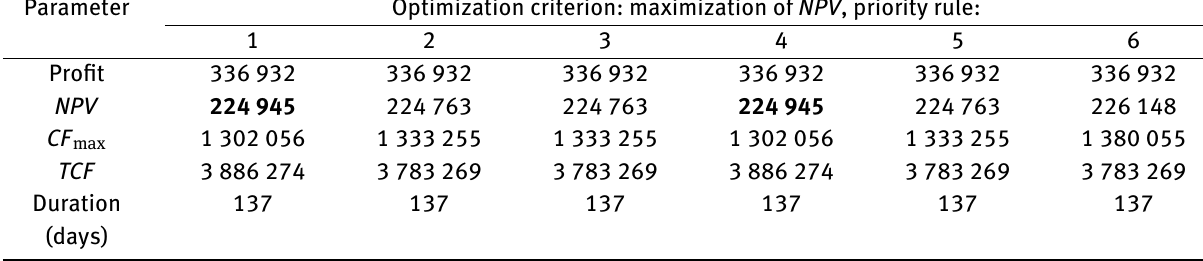
Table 6: Results of the maximization of project NPV with selected priority rules. Parameter